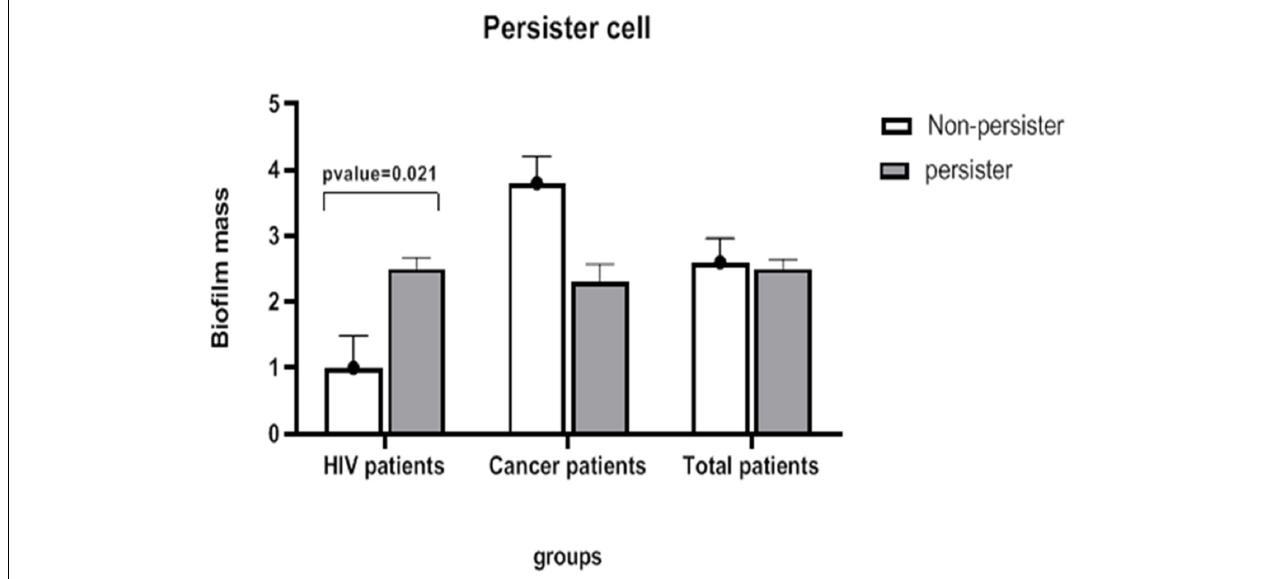
FIGURE 4 | The mean severity of biofilm in the groups of persister and non-persister cells in patients with HIV and those undergoing chemotherapy. A significant relationship between persister cells and biofilm intensity is seen only in HIV-infected patients ( t -test, p -value < 0.05).